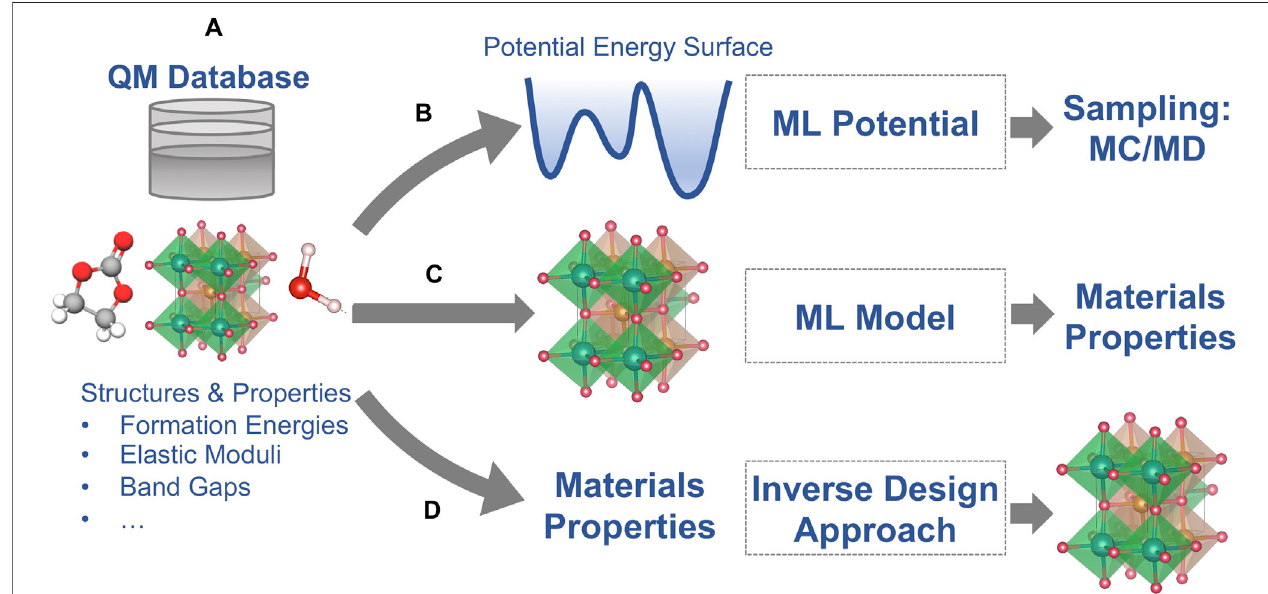
FIGURE2| Schematicofthethreemostcommonapplicationsofmachinelearning(ML)formaterialsmodeling (A) Referencedatafromquantum-mechanical(QM) calculations; (B) ML potentialsfor the regression of potential energy surfaces; (C) ML models for the prediction of materials properties aspredicted by the QM reference method; and (D) Inverse design approaches for predicting structure models for a given set of materials properties.